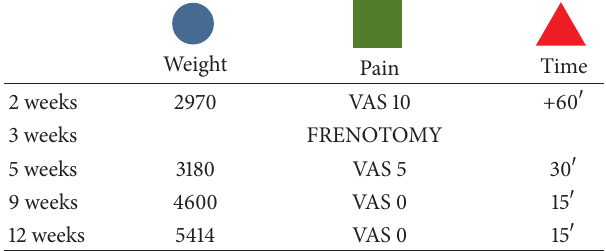
Table 1: Table of the progress of the patient following the CELERE